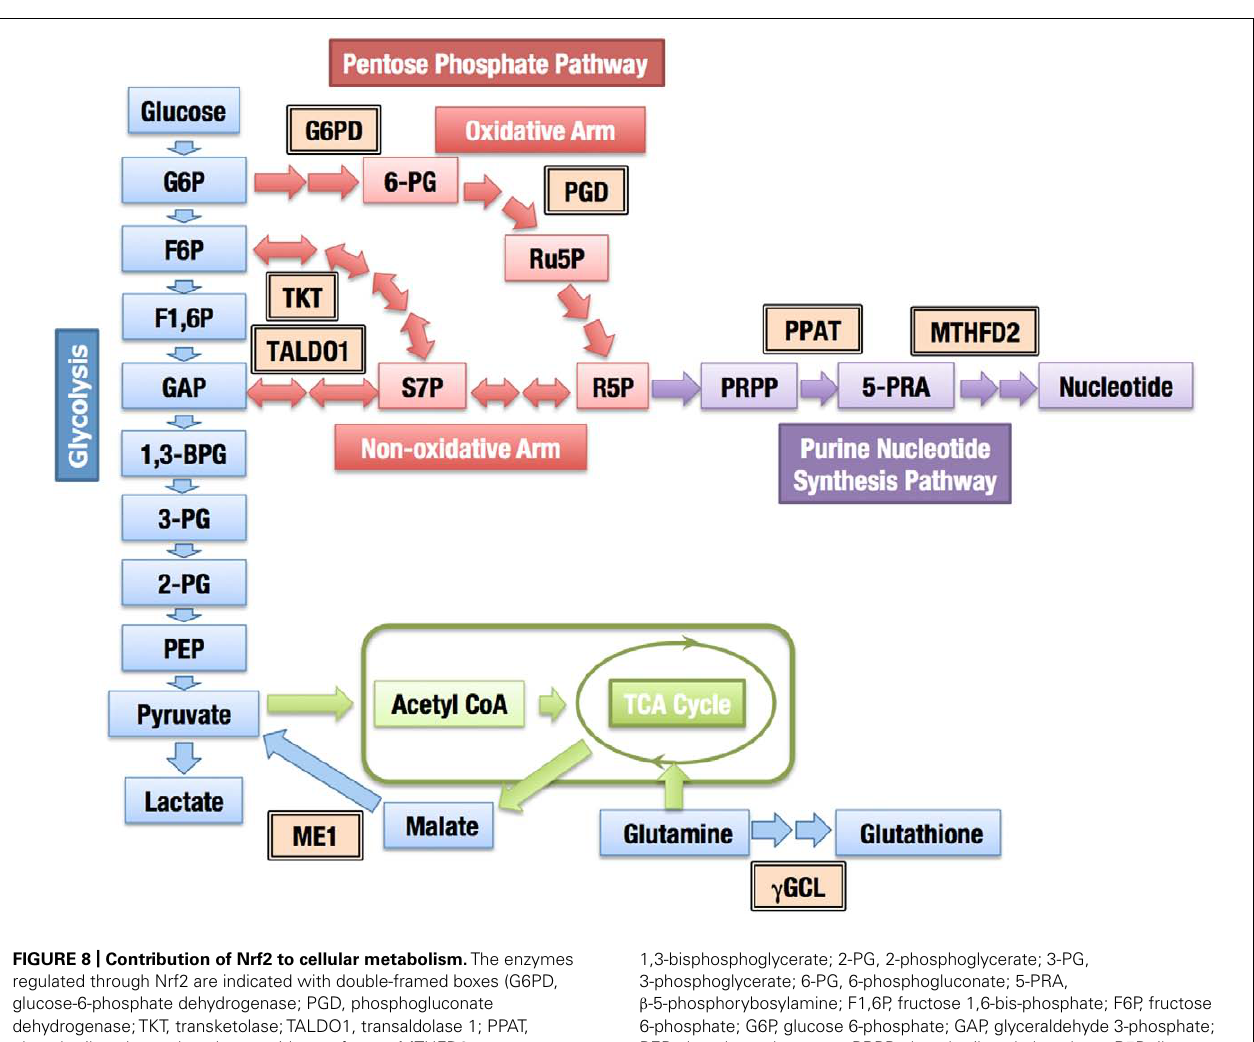
1,3-bisphosphoglycerate; 2-PG, 2-phosphoglycerate; 3-PG, 3-phosphoglycerate; 6-PG, 6-phosphogluconate; 5-PRA, β -5-phosphorybosylamine; F1,6P, fructose 1,6-bis-phosphate; F6P, fructose 6-phosphate; G6P, glucose 6-phosphate; GAP, glyceraldehyde 3-phosphate; PEP, phosphoenolpyruvate; PRPP, phosphoribosyl phosphate; R5P, ribose 5-phosphate; Ru5P, ribulose 5-phosphate; S7P, sedoheptulose